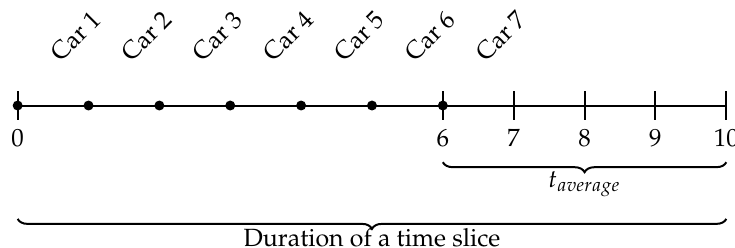
Figure 2. Space-time constraints: time gaps between two consecutive vehicles with the same origin and